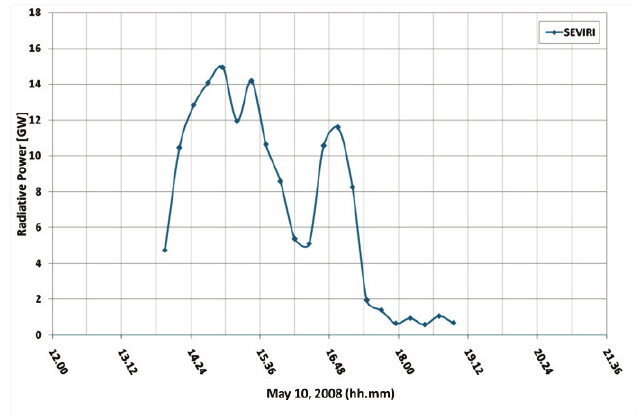
Figure 5. Radiative power computed for the SEVIRI data during the lava fountain that occurred on May 10, 2008.